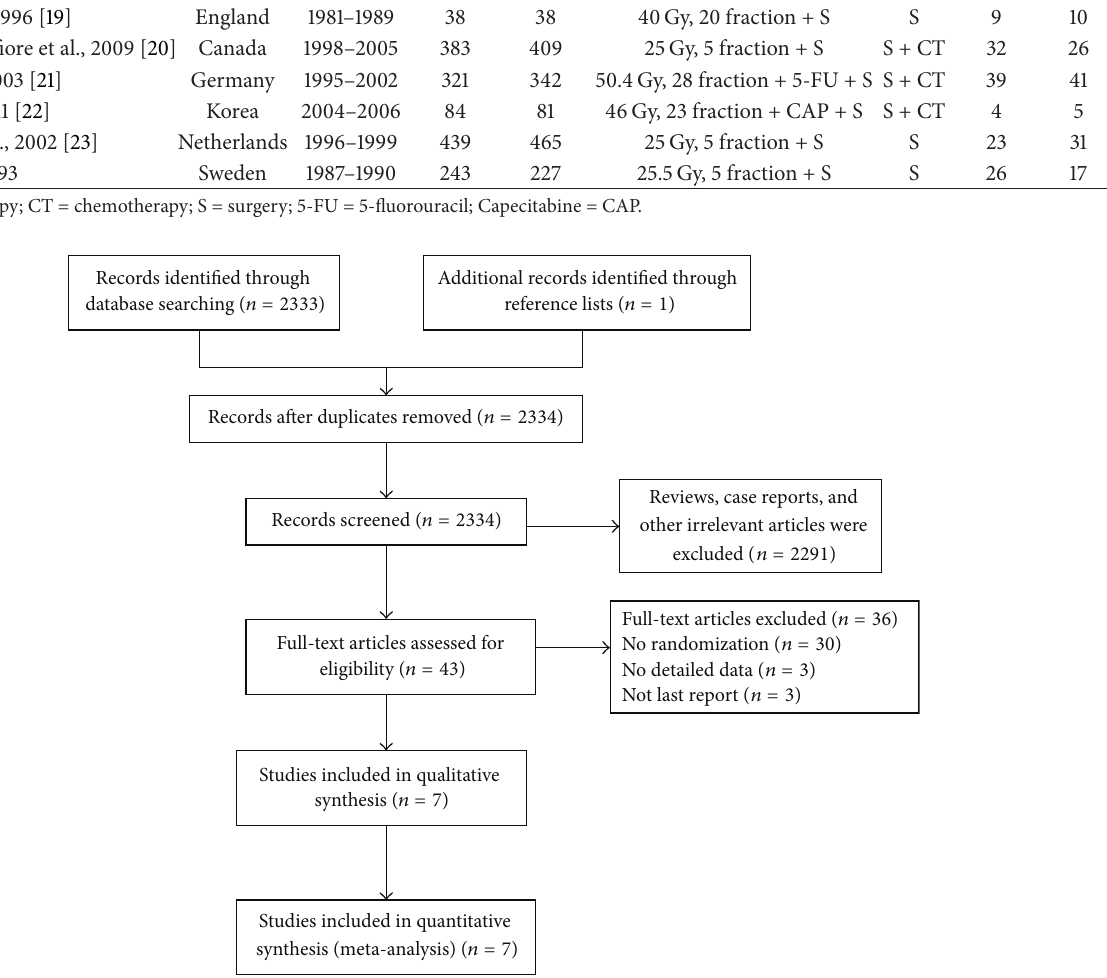
Figure 1: PRISMA flow diagram of the systematic article selection